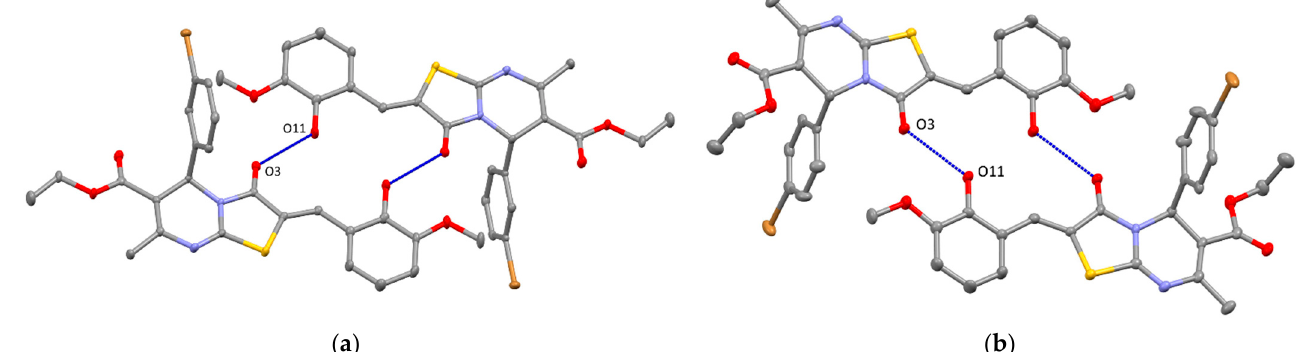
Figure 6. ORTEP-view of supramolecular dimers resulting from intermolecular H-bonding in the crystals of compounds 5 ( a ) and 6 ( b ). The ellipsoids are presented with 50% probability and the H-atoms are omitted for clarity. H-bonding is presented by blue dotted lines.